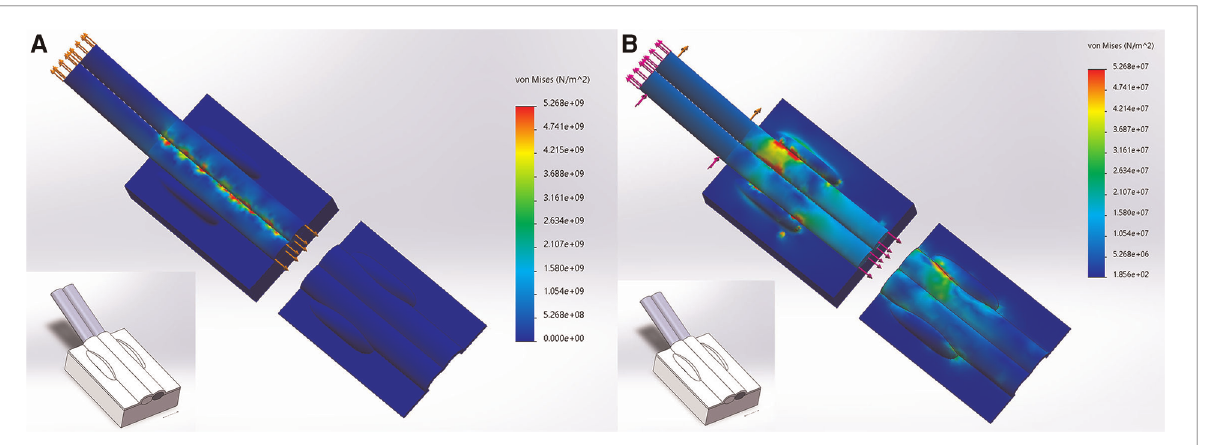
tendons, forming friction rubs between the tendons. When simulating the force of wrist fl exion, the tendon is subjected to longitudinal and oblique traction, and the force is mainly on the tendon and tendon sheath between the bony ridge.